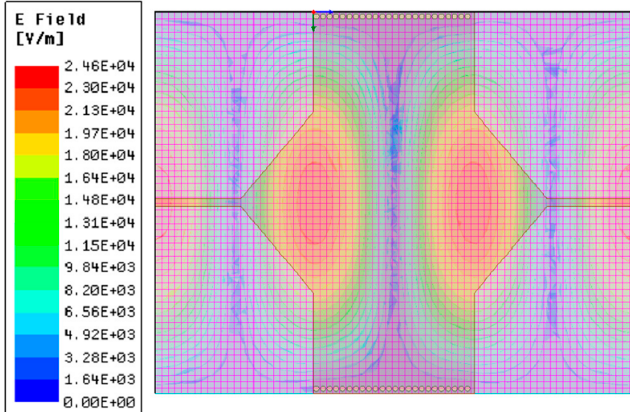
Figure 7. Discretized SIW with SIW–microstrip transition operating under mode TE 3,1 . Electric field discretized for 5.8 GHz using nonmodel object cells of size 0.34 mm in Ansys HFSS. The mode of interest had its closest neighbors at 4.19 GHz and 7.42 GHz. Again, max((cid:1874)) was equal to 7. The electric-field configuration for the empty filter at 5.8 GHz showed maxima in the tapered transition. For 4.19 GHz, the maximum appeared in the center of the SIW; however, the electric mode around 7.42 GHz shared different maxima with 5.8 GHz. Modal recombination was mandatory. The only null area where vias could be embedded was in the center of the SIW; any other would attenuate the mode of interest. Eight iterations are necessary to reach proper modal recombination. The obstacles’ dimensions and positions were obtained using the equivalent impedance expressions with MATLAB, and then optimized using HFSS tool Optimetrics. Initially, a wide via of 0.542 mm radius was added at the center of the SIW, thus canceling the lower modes. Including two more vias, the higher mode was downshifted. Lastly, including two vias of 0.1355 mm radius and two of 0.271 mm radius allowed for appropriate modal recombination. The final filter had the equivalent filter in Figure 8a, and its dimensions are shown in Figure 8b. The structure consisted of an SIW–microstrip tapered transition with two cavity resonators constructed by the smart-obstacle position methodology. The filter had a 20 dB matching band of 5.76–5.84 GHz (Figure 8c) with a mean insertion loss of 0.02 dB.